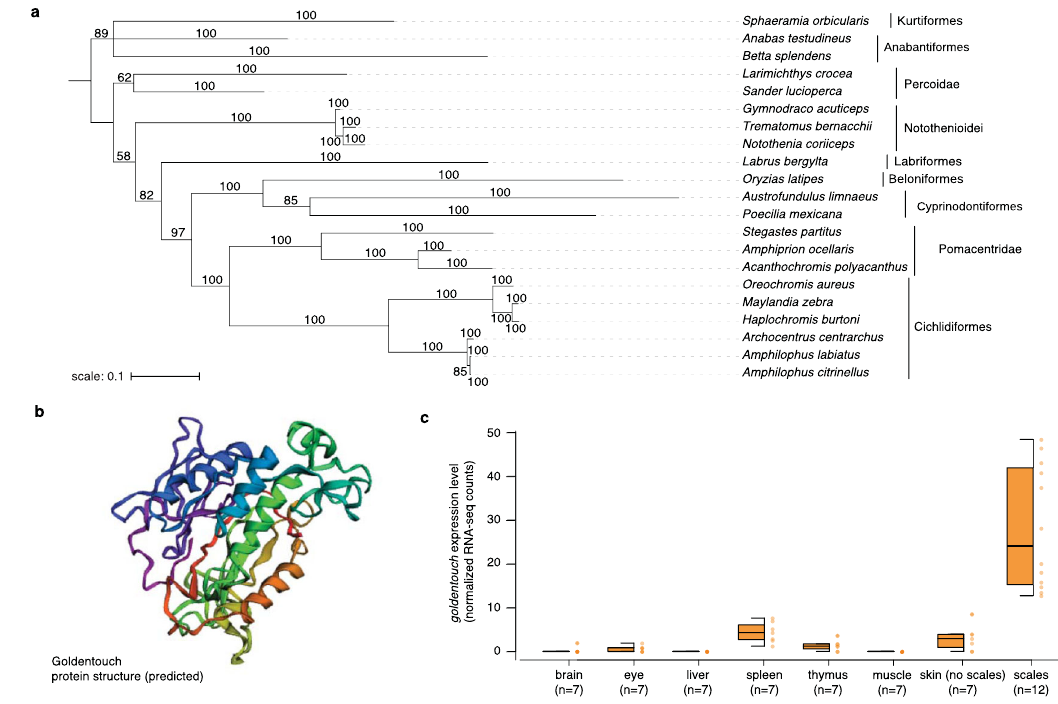
Fig. 3 Phylogenetic, structural, and expression analyses of goldentouch . a Bayesian phylogenetic reconstruction of goldentouch , which was only found in the order Percomorpha and could, for example, not be detected in zebra fi sh, Danio rerio , a non-Percomorpha. b Three-dimensional structure prediction of goldentouch . c Expression of goldentouch is mostly restricted to scales, with some expression in the underlying skin and in spleen tissue (center line, median; box limits, upper and lower quartiles; whiskers, 1.5× interquartile range; points,